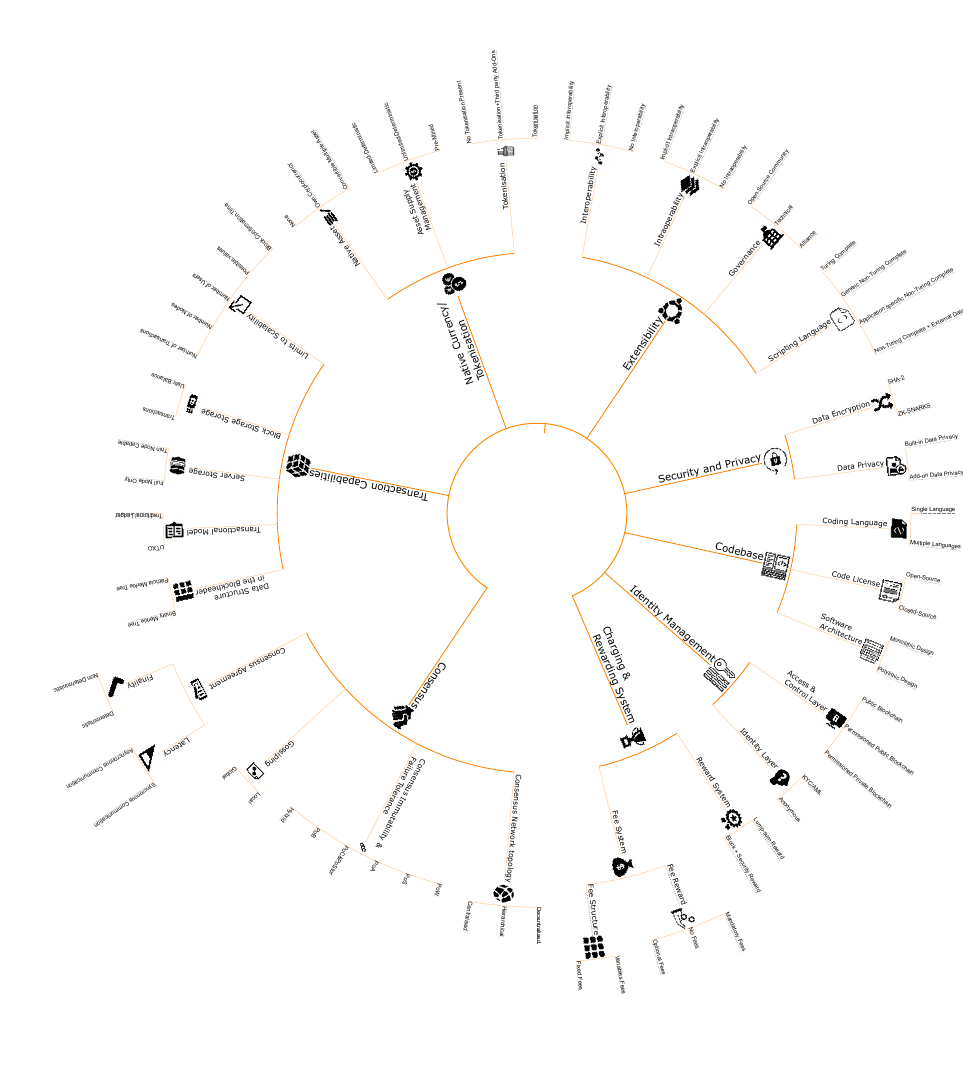
Fig. 1. Blockchain Taxonomy Tree: A representation of the taxonomic deconstruction of blockchain-based